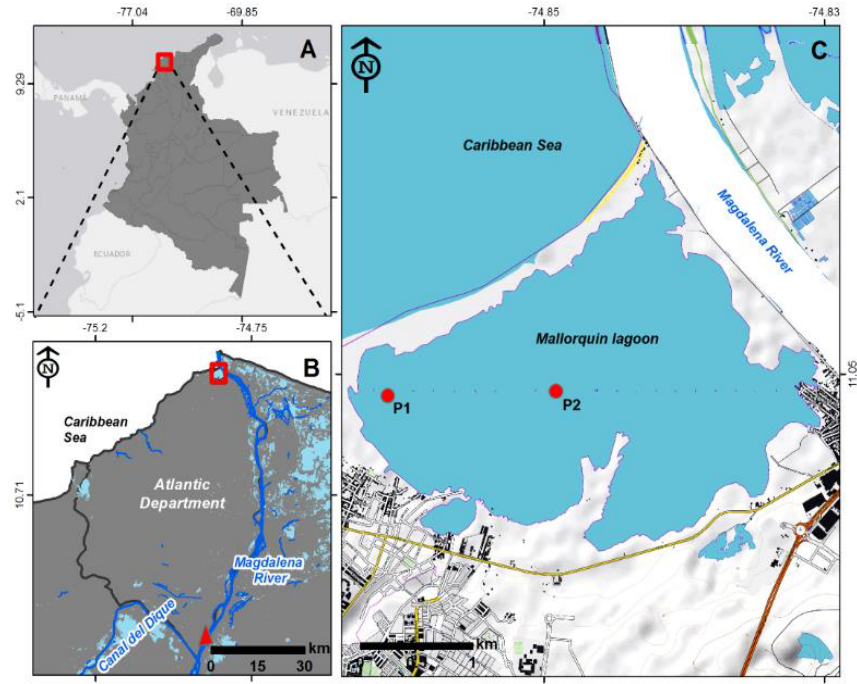
Fig. 1 : Geographic location of the study area along with the measurement stations used in the calibration process (P1 and P2).